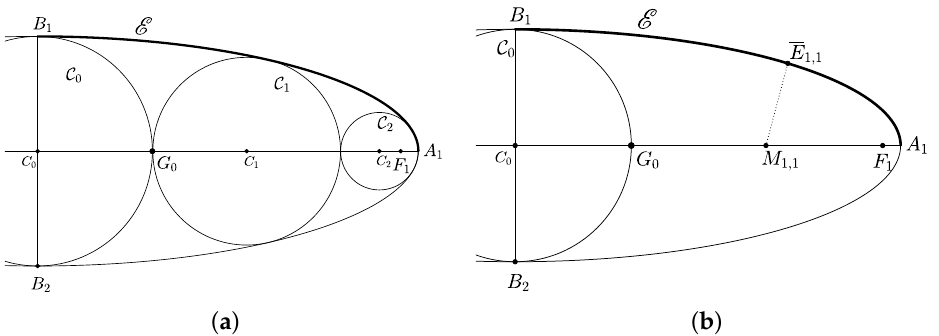
Figure 3. ( a ) Detail of the scaffolding in Figure 2a. ( b ) Determination of center and radius of circle C 1 shown in ( a